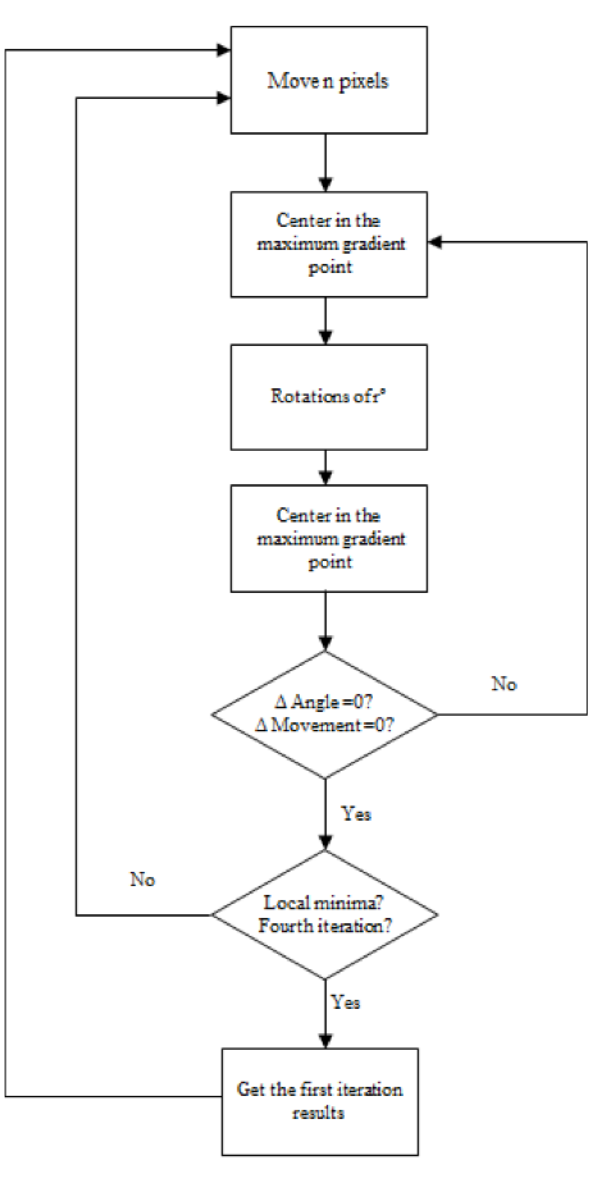
Figure 7. Flow chart of the algorithm.